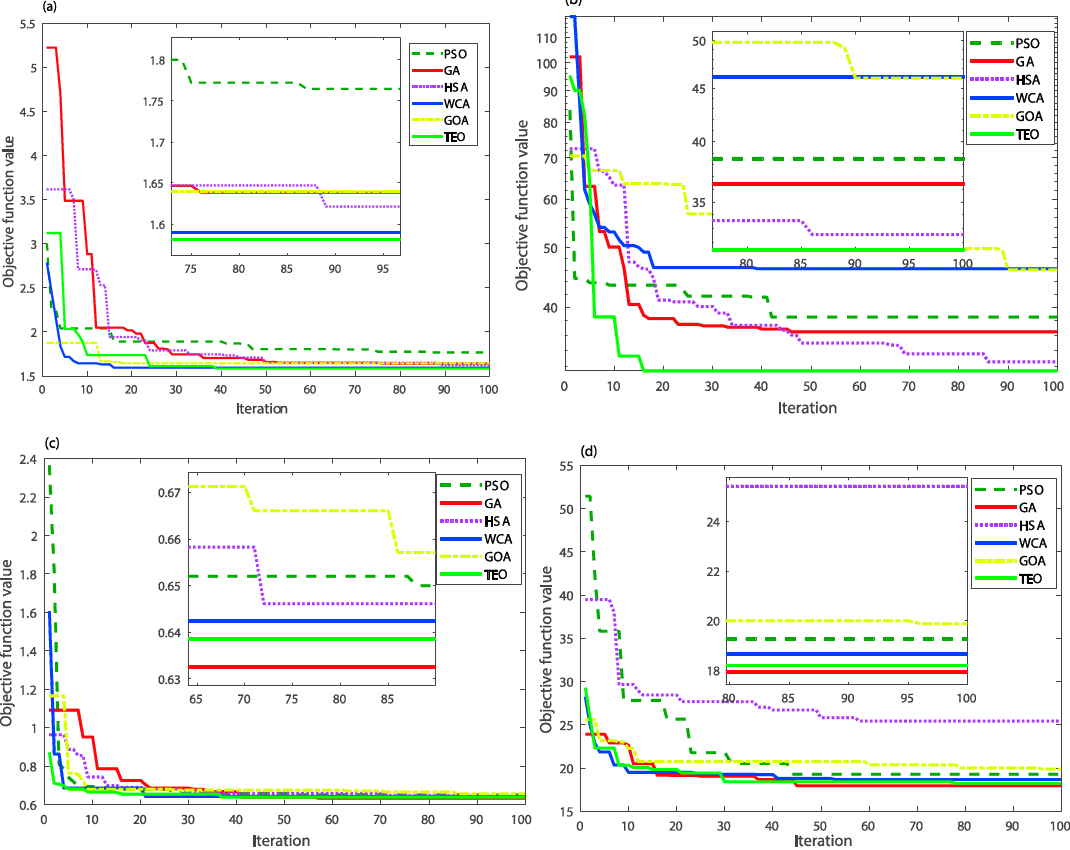
Figure 7. Convergence rates comparison: ( a ) IAE criterion; ( b ) ISE criterion; ( c ) ITAE criterion; ( d ) ITSE criterion.